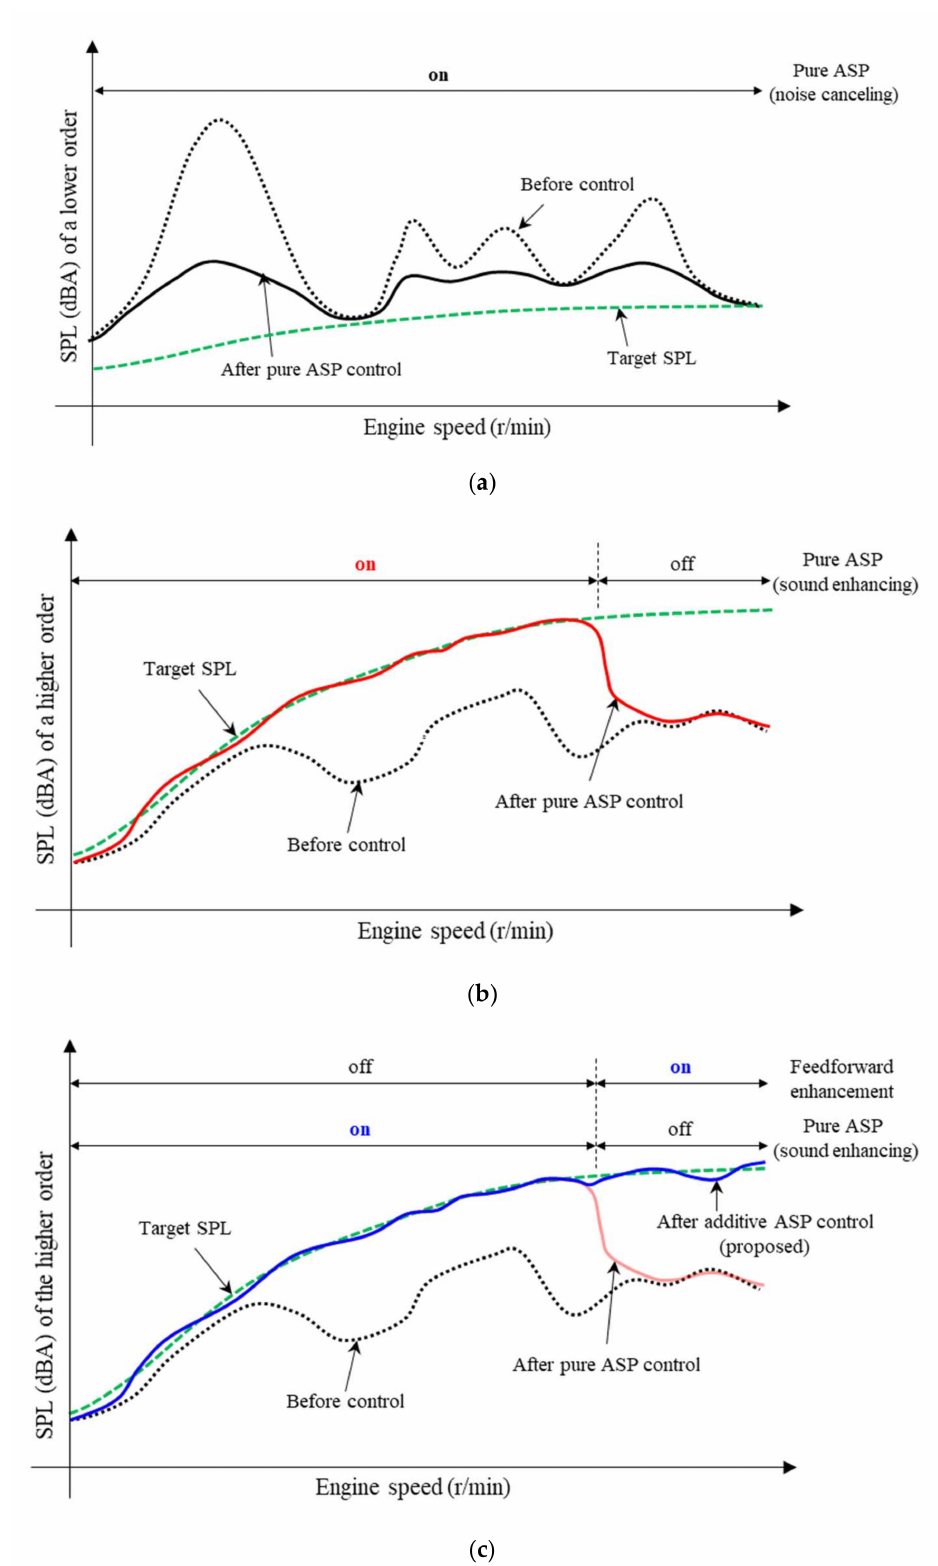
Figure 2. Pure and additive ASP control schemes. ( a ) Noise canceling for a lower order and ( b ) sound enhancing for a higher order using the pure ASP algorithm. ( c ) Sound enhancing for the higher order using the proposed additive ASP algorithm with the feedforward